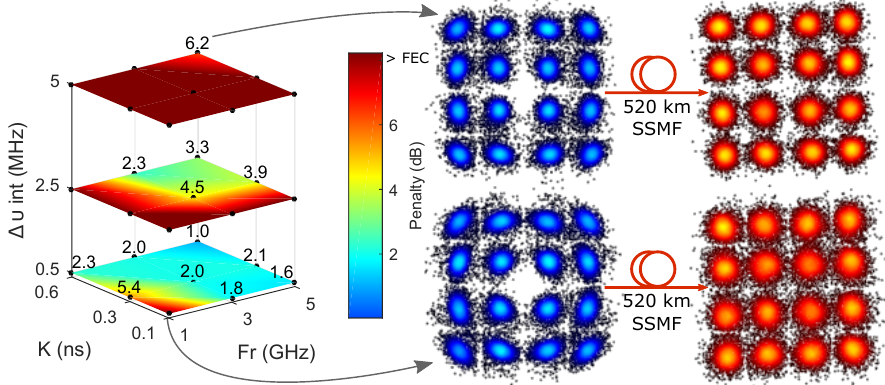
Figure 8. Experimental results for transmission when phase noise comes from local oscillator (LO)